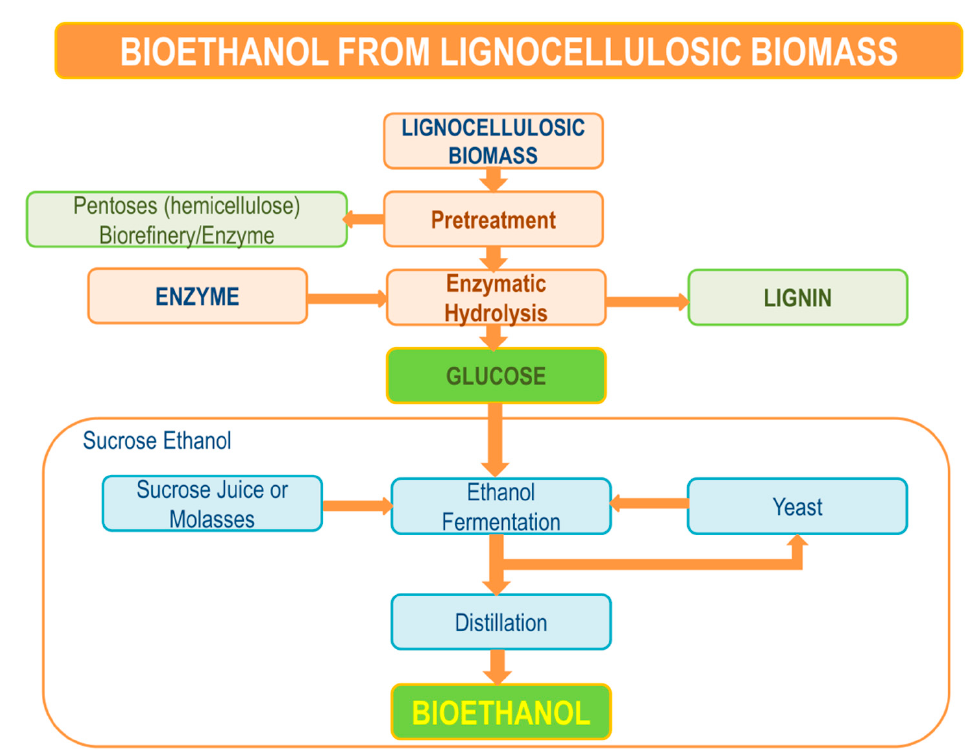
Figure 6. Enzymatic hydrolysis pathway. Figure 6.